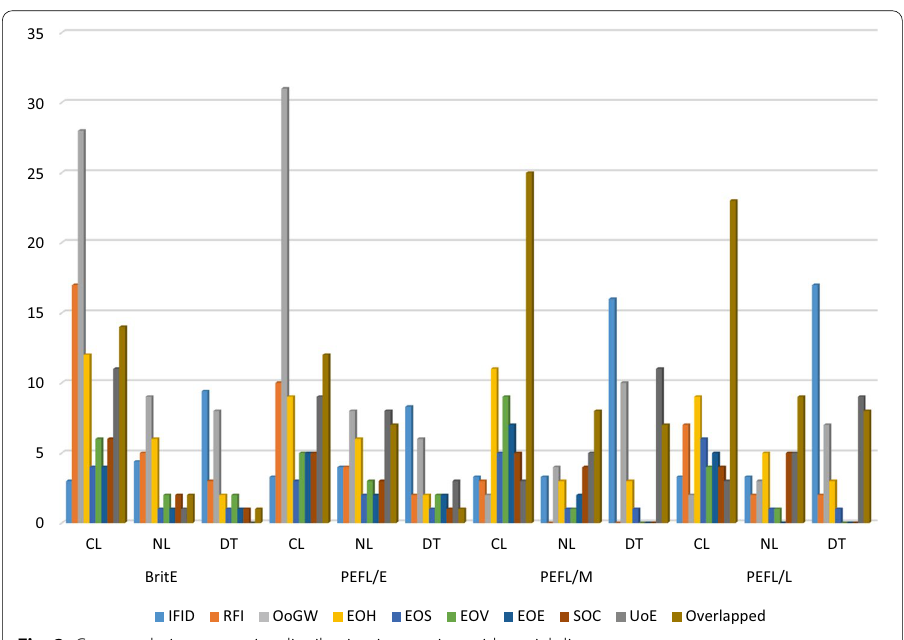
Fig. 2 Congratulation strategies distribution interacting with social